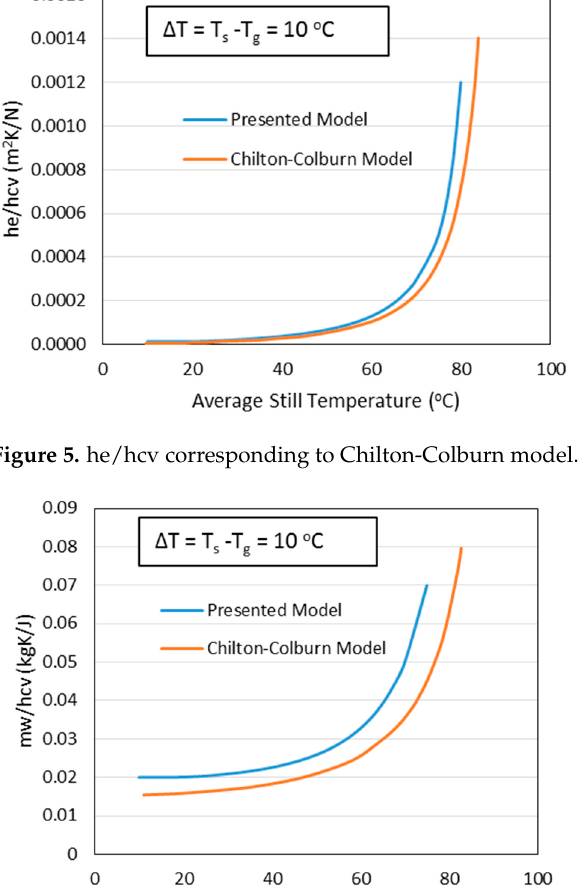
( d ) Figure 7. Effect of vacuum pressure on the production of a geothermal solar still. ( a,b ) represent the analysis for a winter’s day on 15 January 2018. ( c , d ) represent the analysis for a summer’s day on 17 June 2018.